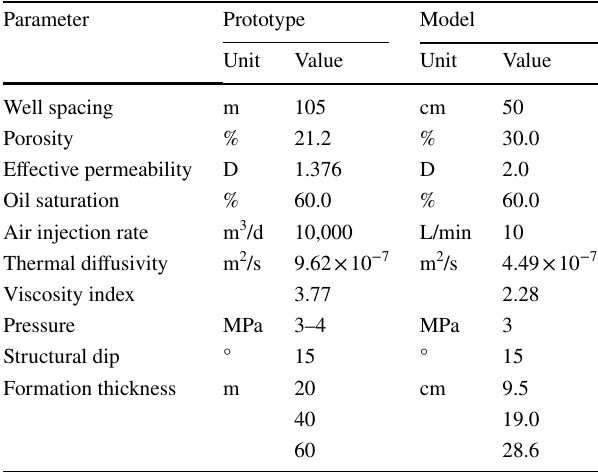
Table 1 The scaling factors between the model and prototype